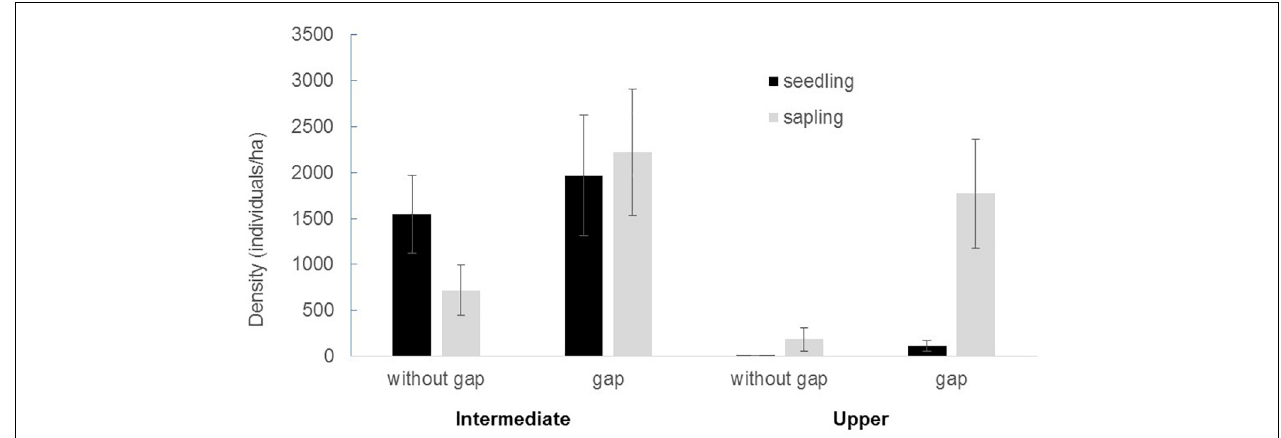
FIGURE 1 | Seedling and sapling density by elevational band (intermediate 3050 to 3300 m a.s.l., upper band 3301 to 3550 m a.s.l. ) and canopy type (with and without canopy gap).